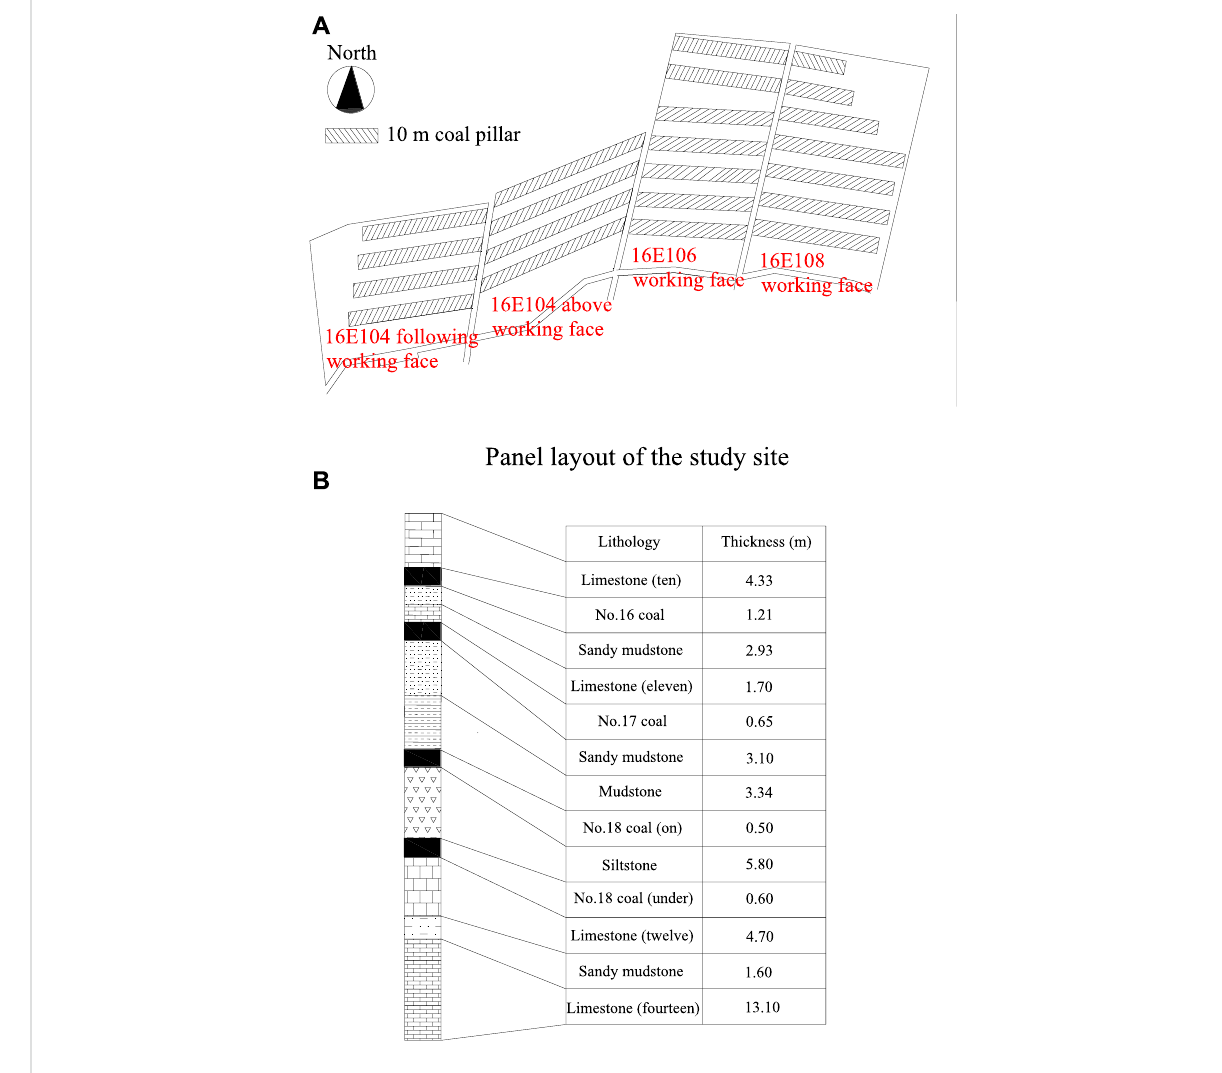
Figure 2. With the depletion of recoverable reserves, the mine is facing the threat of closure and shutdown.